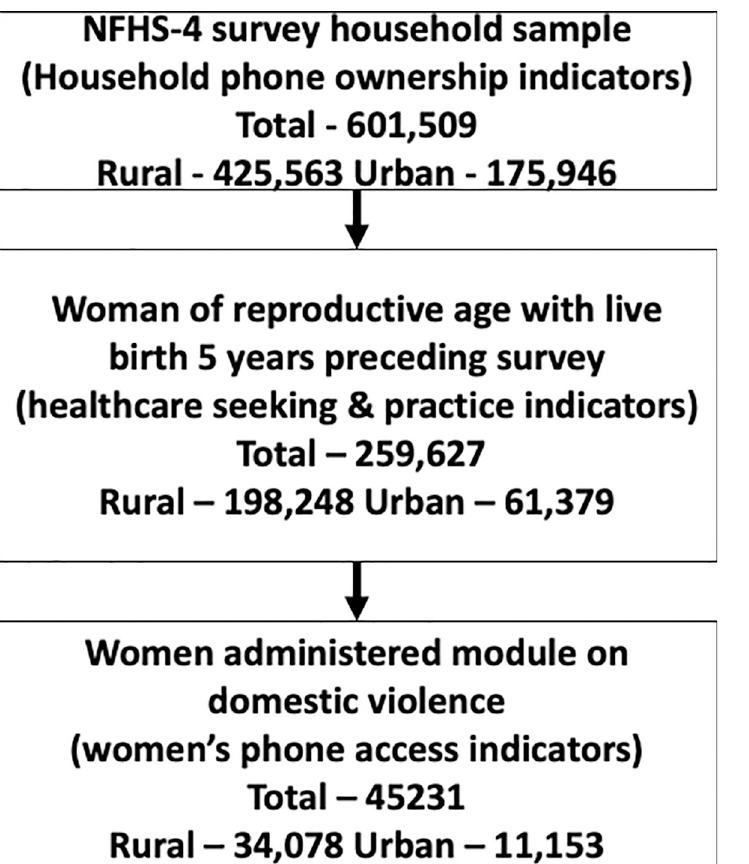
Fig 2. Flowchart for study sample from NFHS 2015–2016.